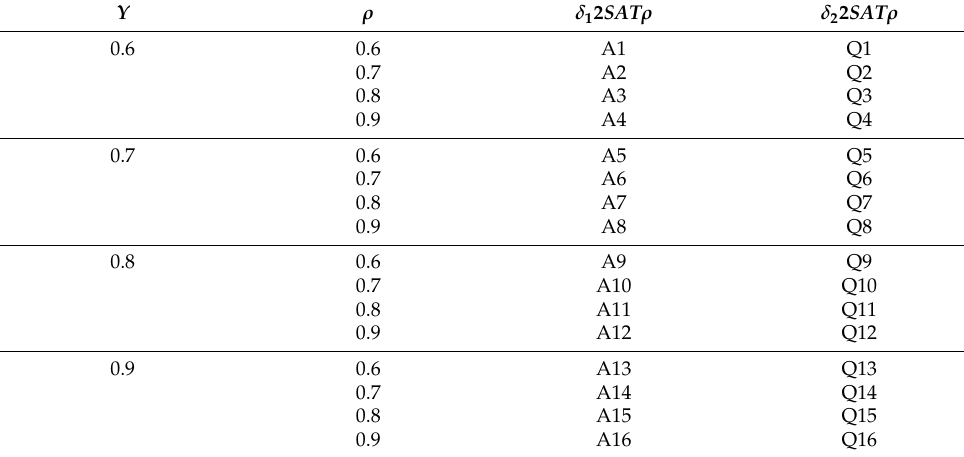
Table 7. The logical symbols in the